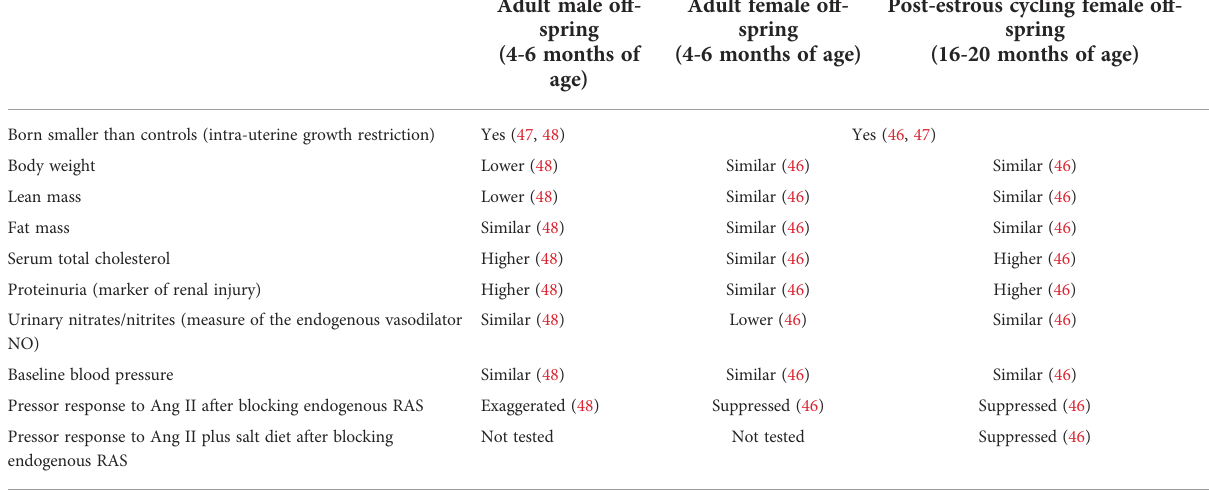
TABLE 1 Characteristics of female and male offspring of DHT-treated dams compared to their age- and sex-matched